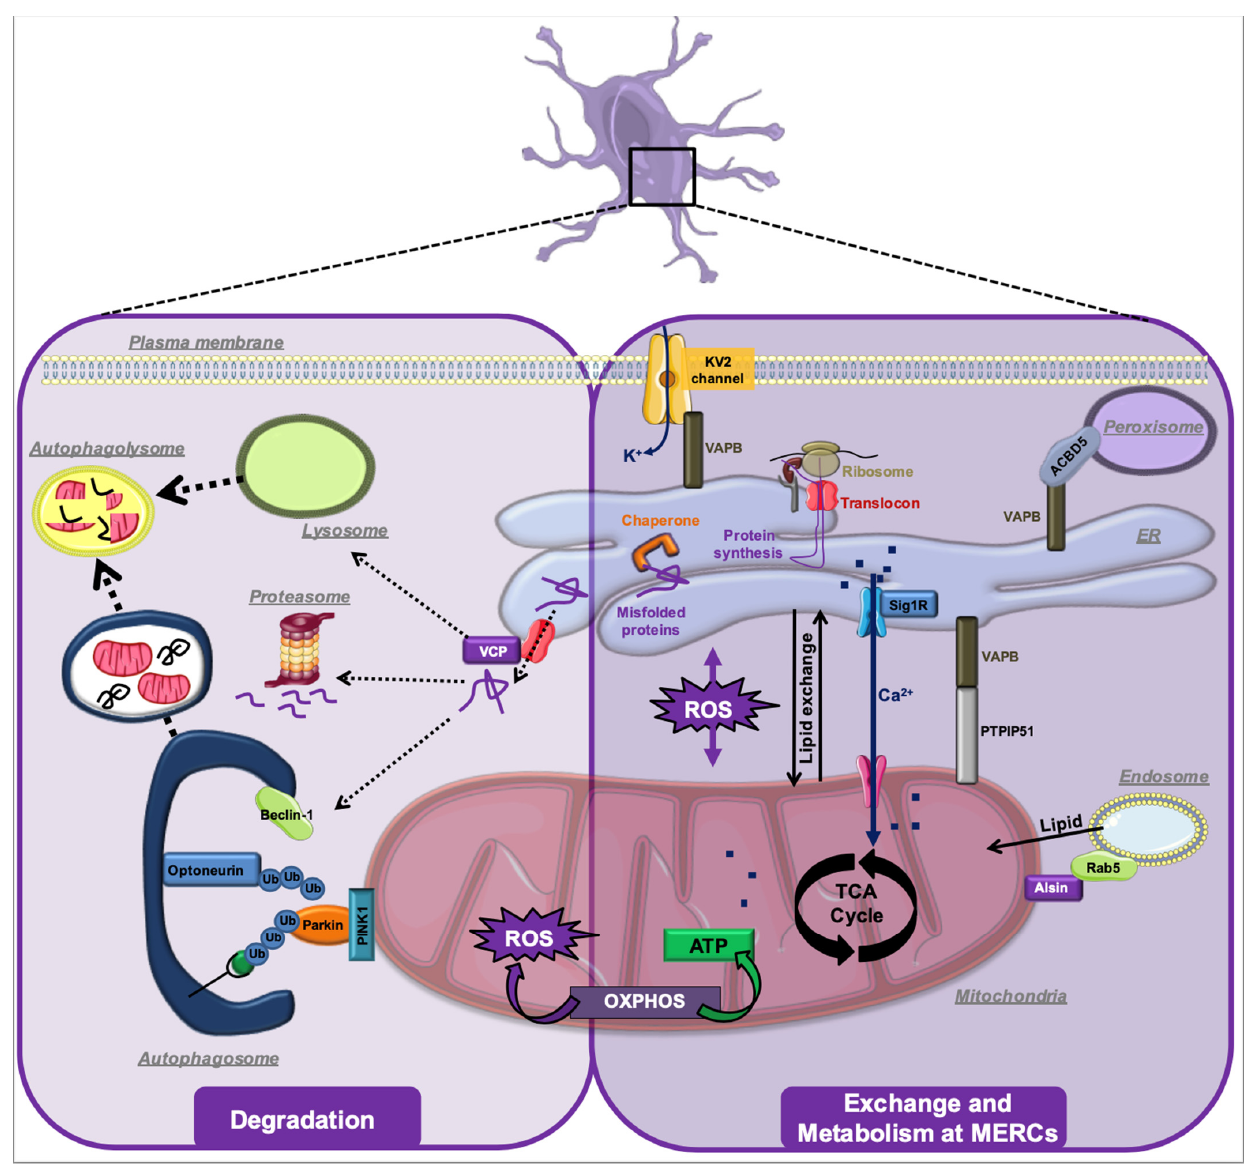
Figure 2. The context of MERC-associated ALS-related MCS proteins. For details, see text.